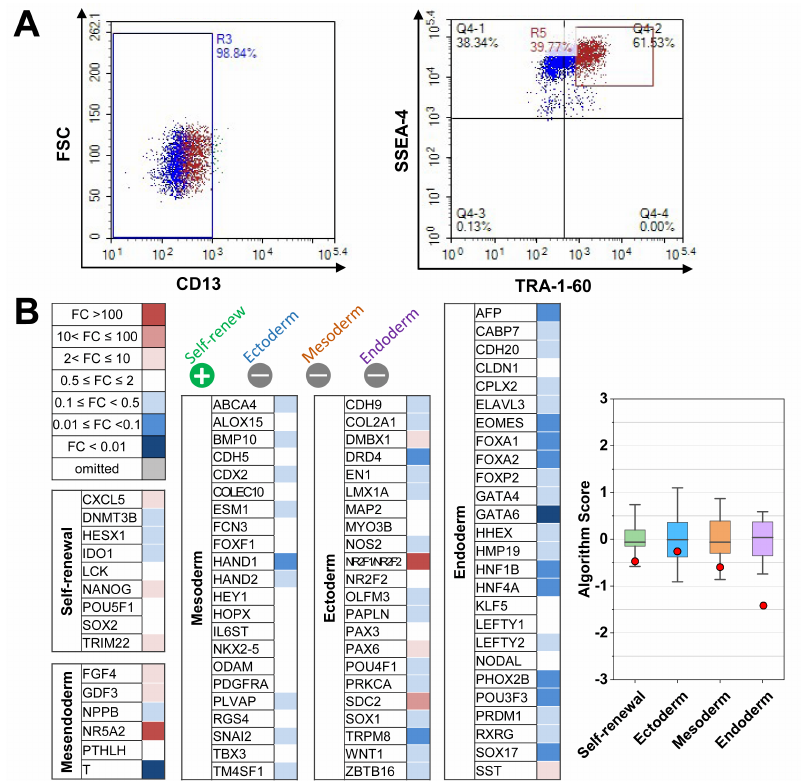
Figure 1. Quality control of human induced pluripotent stem cells (hiPSCs) hFSiPS1: ( A ) Repre- sentative FACS traces for CD13 (human fibroblast marker), TRA-1-60, and SSEA-4 (pluripotency markers) combination. Gating of CD13-negative population (left) and TRA-1-60-positive/SSEA-4 positive (right). ( B ) Scorecard analysis of sorted hiPSCs showing heatmaps of self-renewal genes and lineage-specific genes for mesendoderm, ectoderm, mesoderm, and endoderm (left). The Box-plot data from scorecard analysis (right). Red dots indicate sorted algorithm score of hiPSCs. Color box score is the range of scores of the undifferentiated reference stem cells